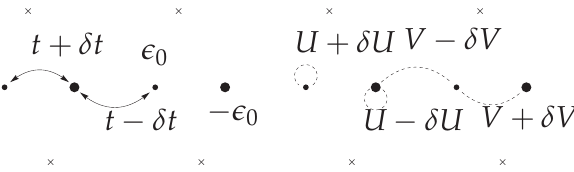
Figure 1. One dimensional alternating extended Hubbard model. The small and big full circles depict higher and lower potential energies, and crosses refer to the positions of anions in systems like (TMTSF) 2 X , (TMTTF) 2 X and their